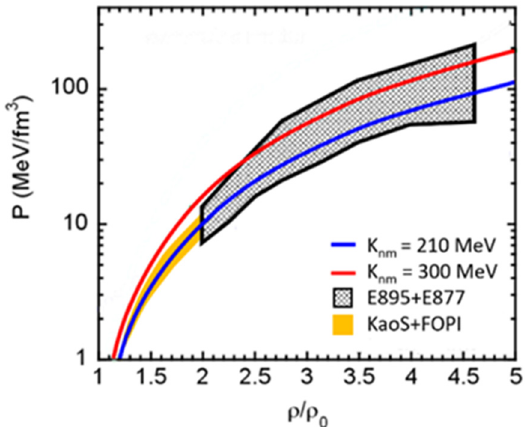
Figure 3. Pressure as a function of baryon density for symmetric nuclear matter. The grey hatched area represents the constraint provided by proton flow data taken at AGS [17,18]. Yellow area: Constraint from fragment flow and kaon data taken at GSI [8–13]. Red line: Hard EOS, blue line: Soft EOS [18].